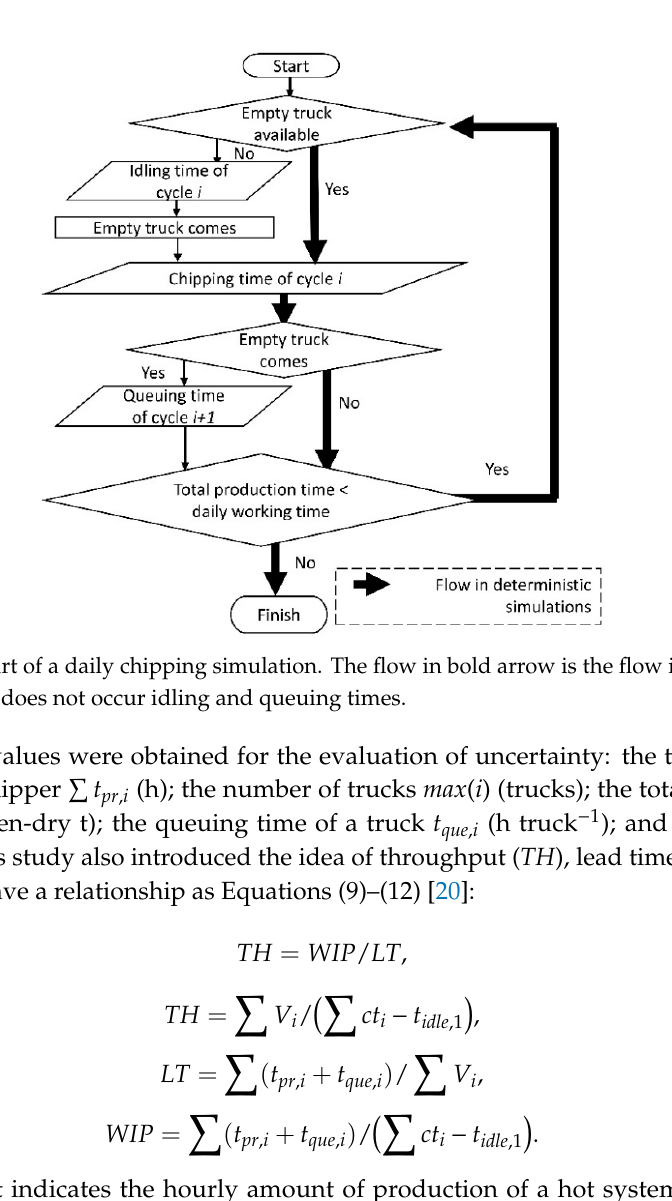
Table 2. Summary of simulation cases. Case